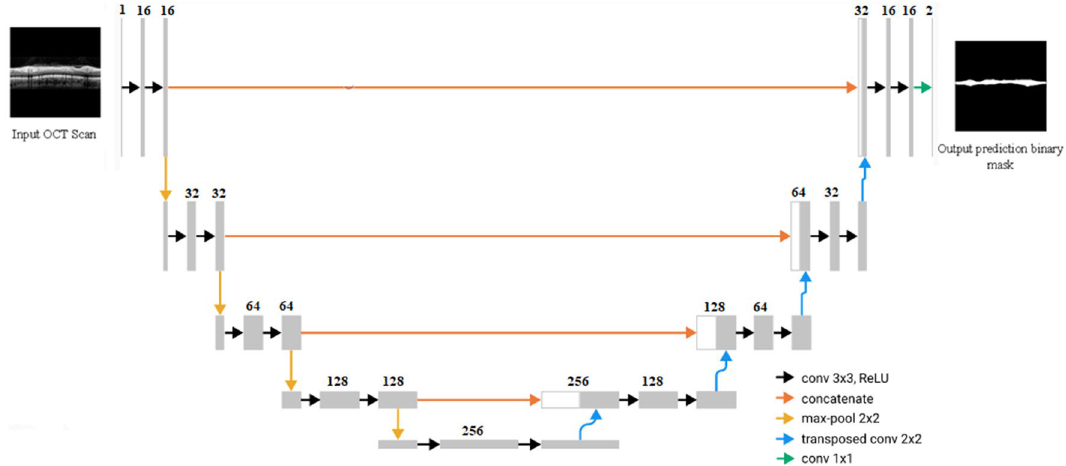
Figure 5. U-Net architecture overview. Input X pass forward the network and prediction mask is created by